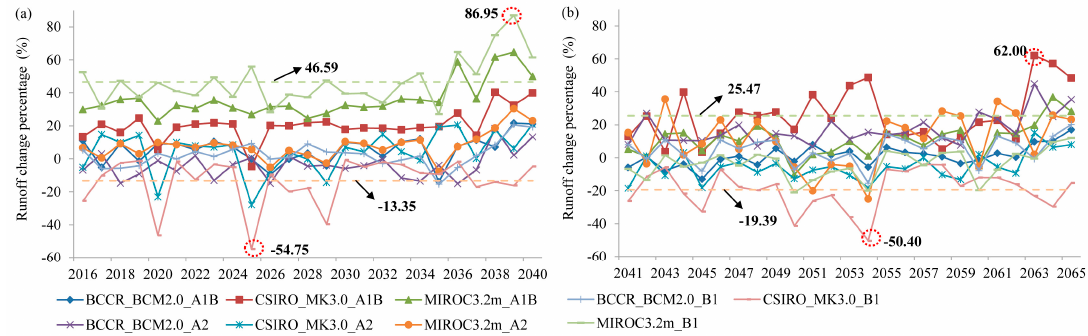
Figure 13. The forecasted runoff change percentage relative to 1980–2004 period under CMIP3: ( a )